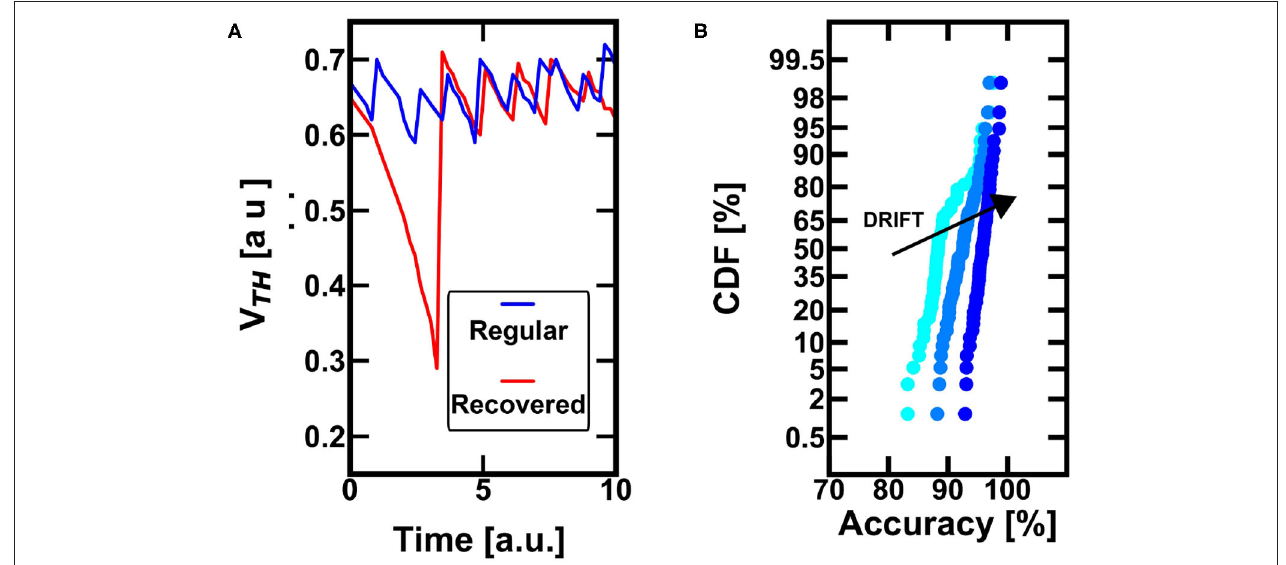
FIGURE 6 | (A) The conductive drift leads to a substantial decrease of the threshold whenever the neuron is not excited (and the device is not reprogrammed), red line. This behavior well fits the bio-inspired forgetting and can lead to the recovery of a wrong spiking specialization toward improved classification. On the other hand, blue line, if the neuron is regularly excited (even if not often in time), the drift effect does not lead to active forgetting. (B) The conductance drift of the PCM devices has a positive effect for the recovery of neurons which committed error during the classification, such as neurons that have specialized on “wrong” patterns. At increasing drift of the control PCM device, the internal threshold gets progressively smaller, and the neuron is induced to fire again to the presentation of another pattern (eventually the “good” one). This favorable scenario is due to the fact the pattern information is correlated in time, while the errors are not. Thus, the drift effect can recover the error and increase the probability of accurate spiking activity in